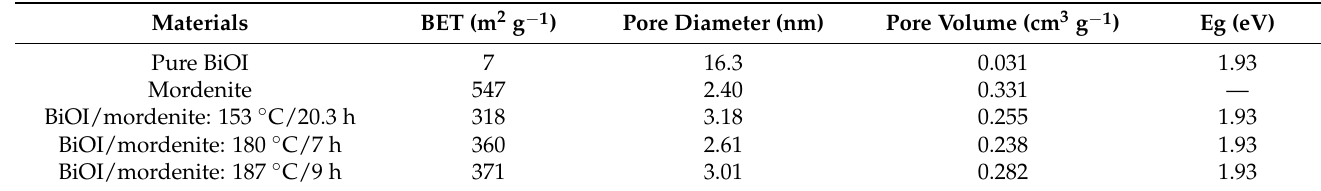
Table 3. Textural and optical properties of parent materials and BiOI/mordenite composites synthe- sized at different conditions of temperature and reaction time.